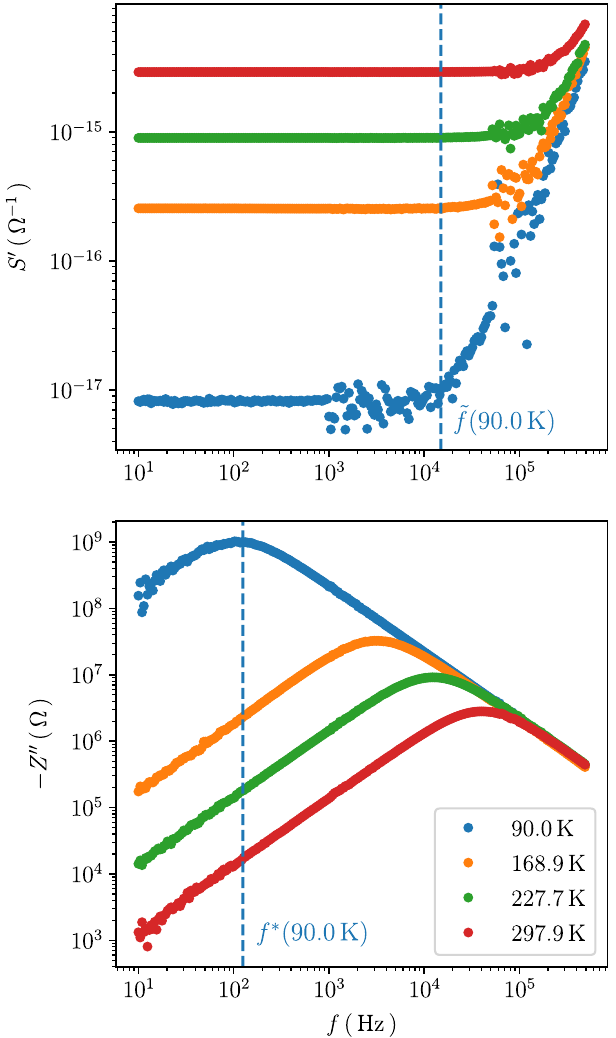
Figure 4. Top: Real part of frequency-dependent conductivity of sample A at temperatures as indicated. Bottom: Corresponding imaginary part of impedance vs. frequency. See text for